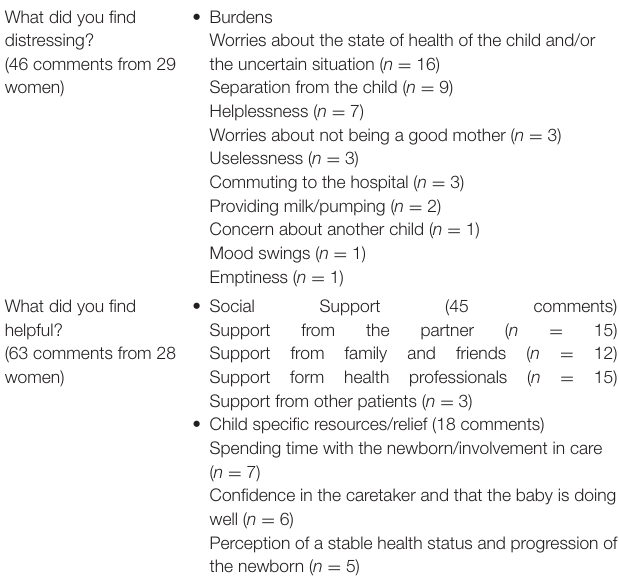
TABLE 3 | Burdens and relief at the NICU during the first 10